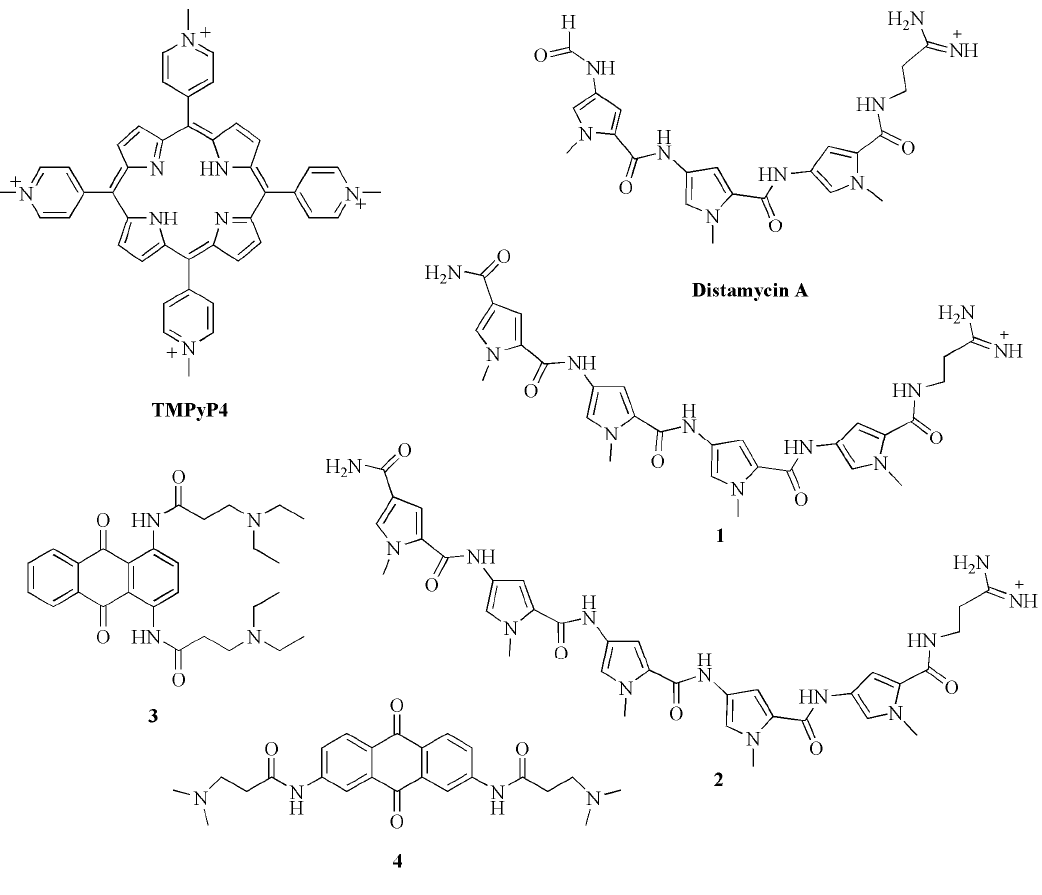
Figure 2. Chemical structures of quadruplex-interactive compounds studied by